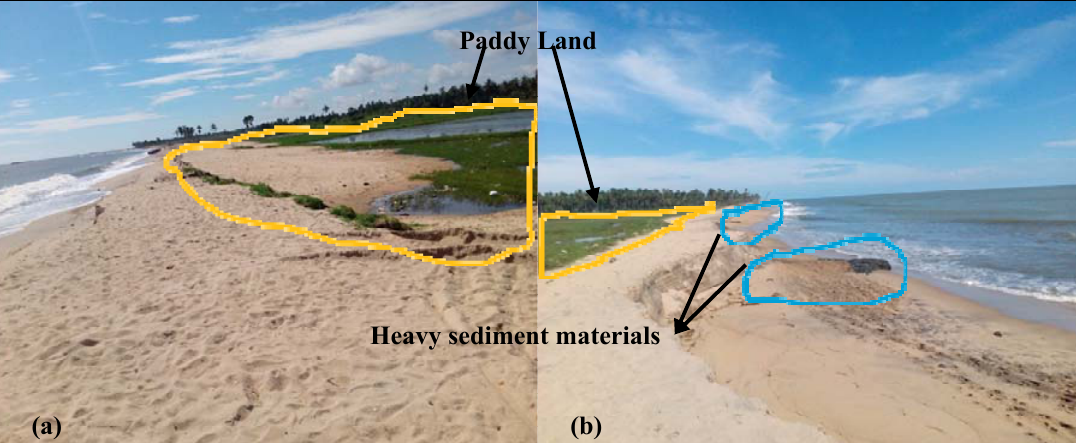
Figure 5. Heavy sediments, i.e., coarse sand deposited in Nochchiyadi paddy land area in Nintavur: ( a ) area before coastal erosion, ( b ) area after coastal erosion (note that bank collapse ca. 1 m in height).